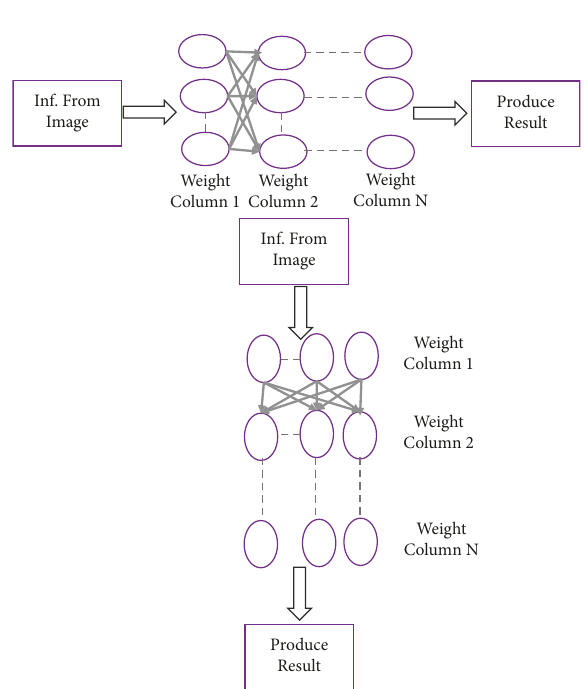
Figure 6: Neural network strategy within pixel random